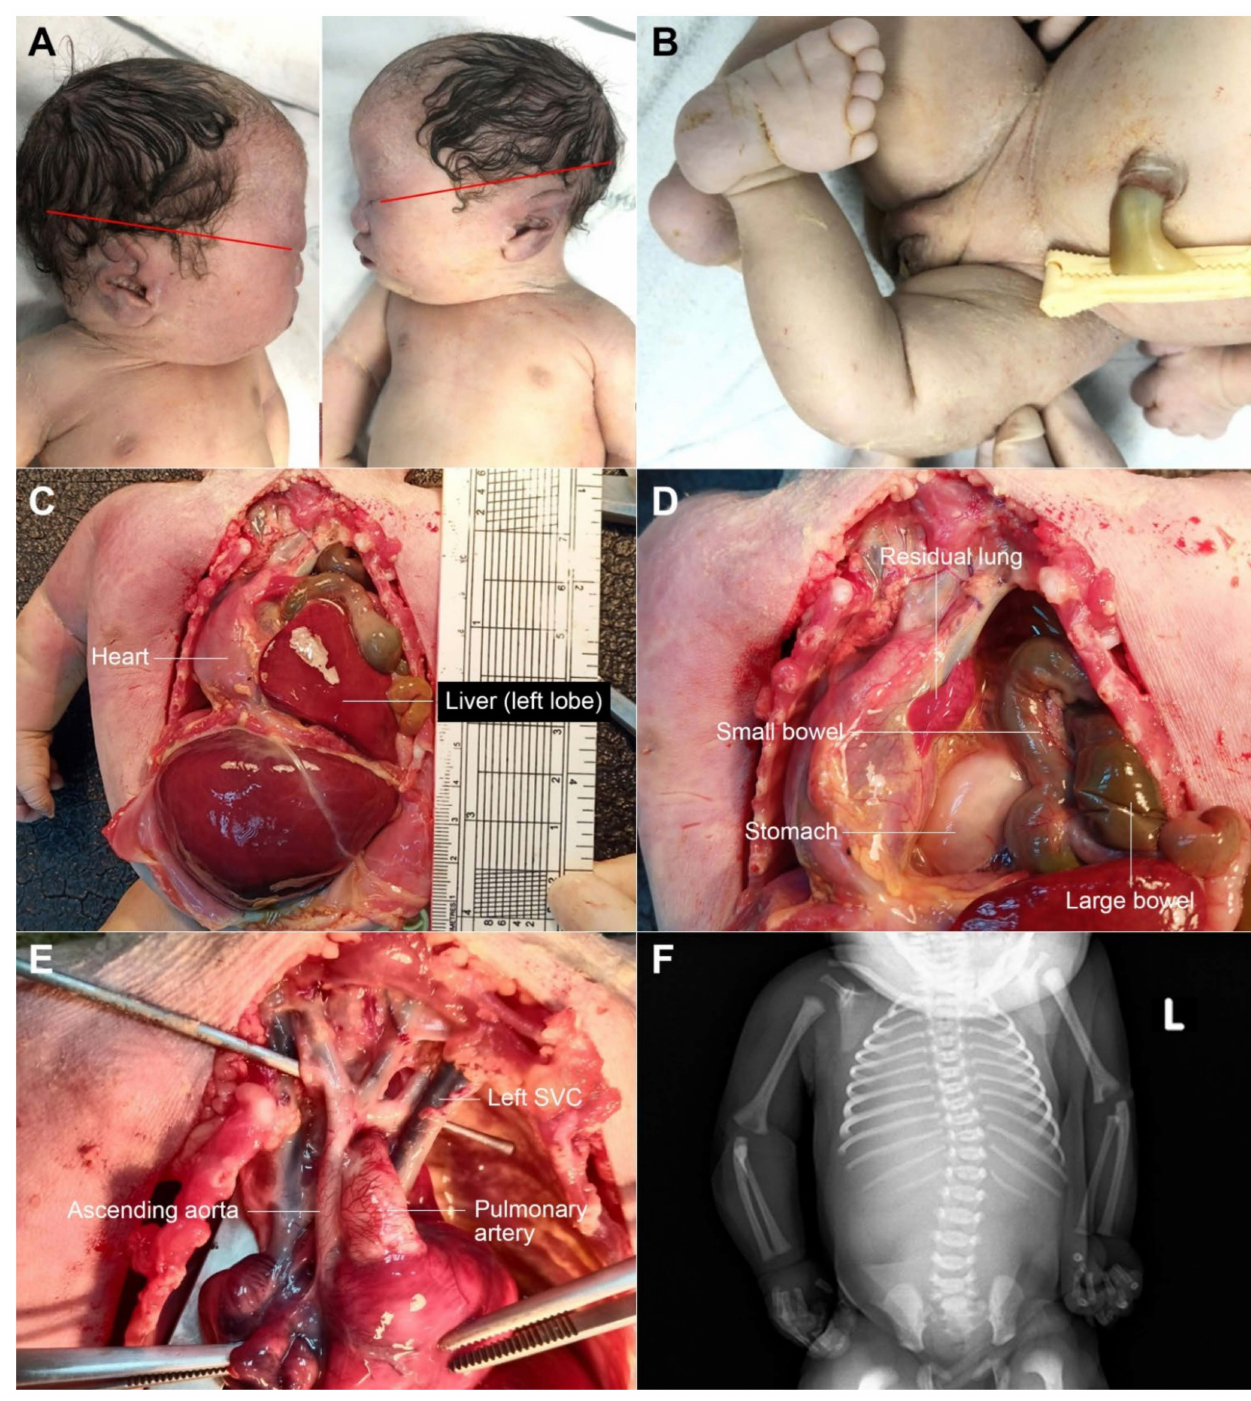
Figure 3. Postnatal findings; ( A ) low-set ears; ( B ) clubfoot; ( C , D ) diaphragmatic hernia; ( E ) small ascending aorta and aortic arch and left SVC; ( F ) scoliosis (L: left